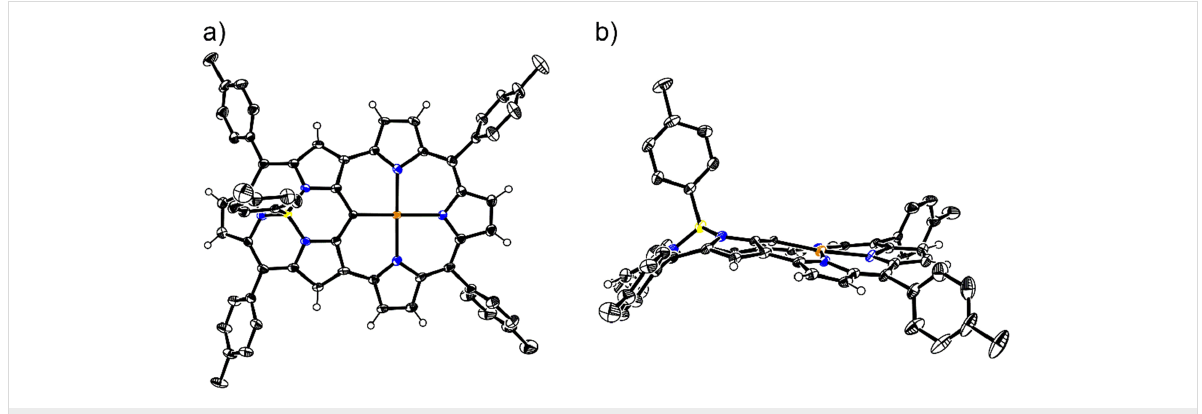
Figure 4: X-ray crystal structures of 3Pd : a) top view; b) side view. Thermal ellipsoids are at the 30% probability level. All hydrogens on tolyl are omitted for clarity.